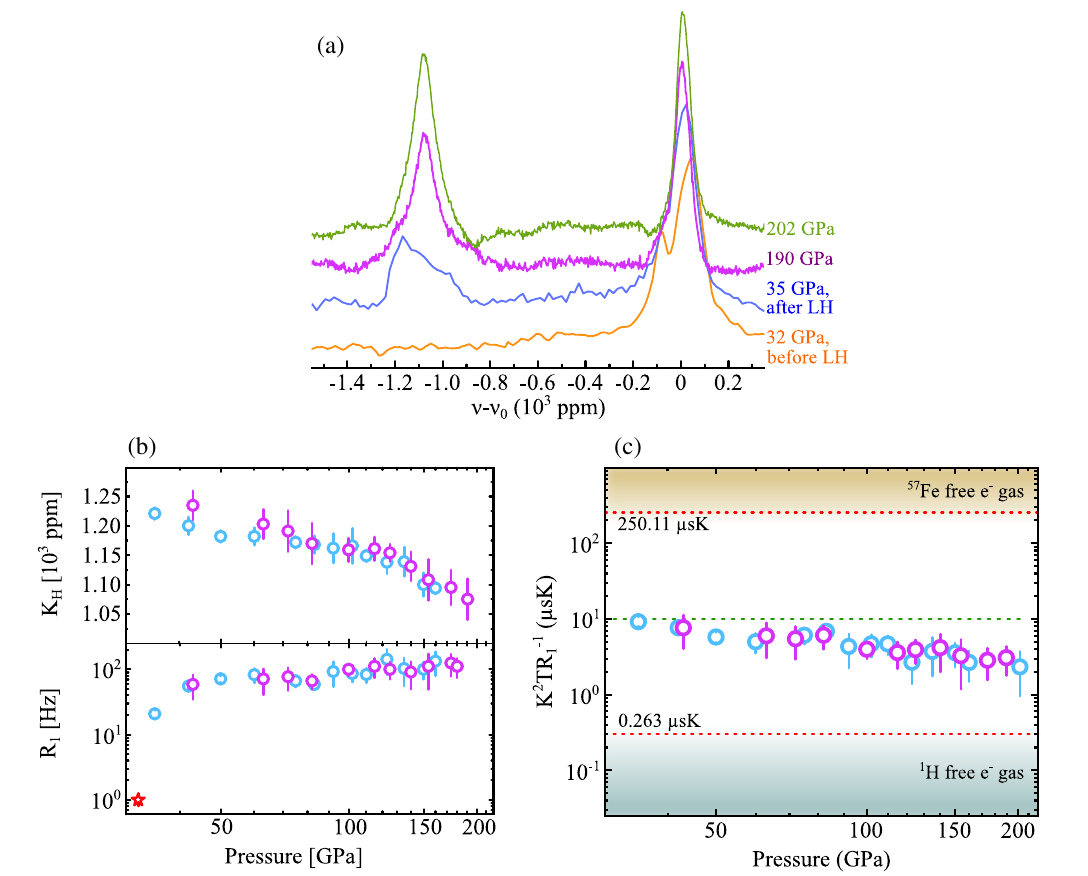
FIG. 2. (a) Hydrogen NMR spectra. Shown are spectra before laser heating at 32 GPa (orange line), directly after laser heating (blue line), and after compression to 190 and 202 GPa (purple and green line, respectively). (b) Summary of Knight shift K hydrogen reservoir (top) and the spin-lattice relaxation rates R 1 (bottom). Blue and purple data points refer to data collected in cells 1 and 2, respectively. The red data point refers to the relaxation rate of the hydrogen reservoir prior to sample synthesis. (c) Pressure dependence of the Korringa ratio. Shaded areas qualitatively depict the regions expected for pure iron (top) and metallic hydrogen